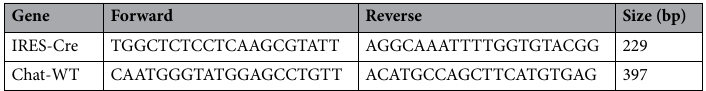
Table 1. Primer sequences for ChAT IRES-cre